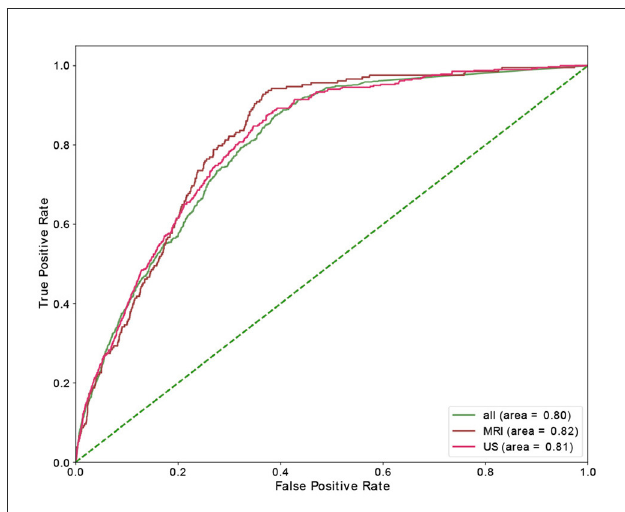
FIGURE3 ROC curve of multivariant RF model for no-show